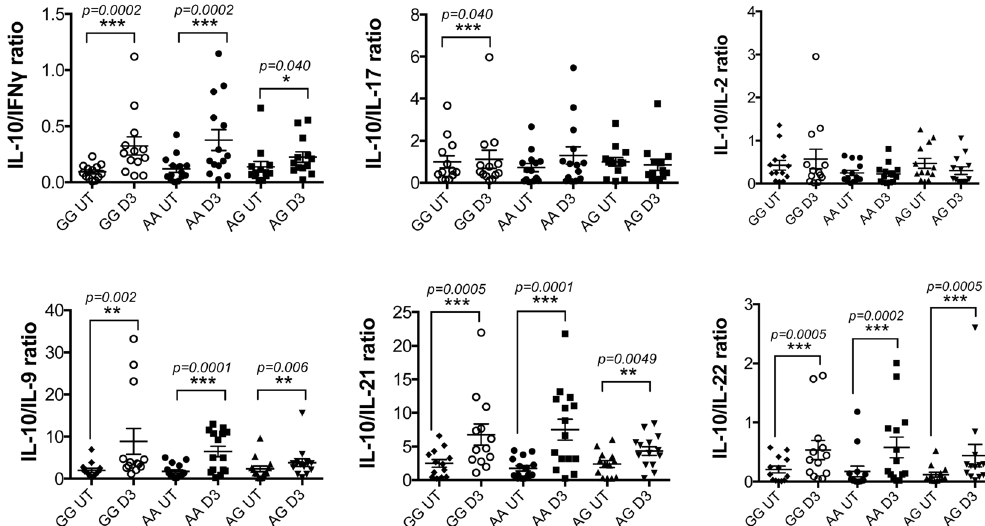
Figure 8. AA, AG and GG individuals respond to vitamin D and produce regulatory cytokines. CD4 + CD25 − T cells were activated in vitro with aCD3 antibody and CHO-CD80 cell line in the presence or absence of 1,25(OH) 2 D 3 . At day 3, cell-free supernatant was collected and tested for the presence of secreted cytokines. Data show the ratio of IL-10 versus pro-inflammatory cytokines IFN γ , IL-17, IL-2, IL-9, IL-21 and IL-22. ** p < 0.01, *** p < 0.001 using Wilcoxon matched-pairs signed rank